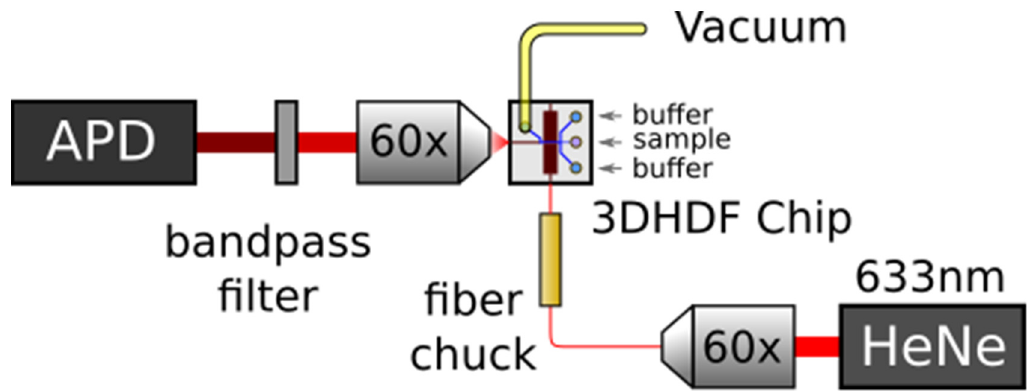
Figure 9. The test system includes the optofluidic chip connected to a vacuum for generating negative pressure to pull sample and buffer fluid through. A 633 nm laser is coupled to the excitation waveguide through an optical fiber to elicit fluorescent photon emission which is collected and detected by an avalanche photodiode (APD) for analysis.